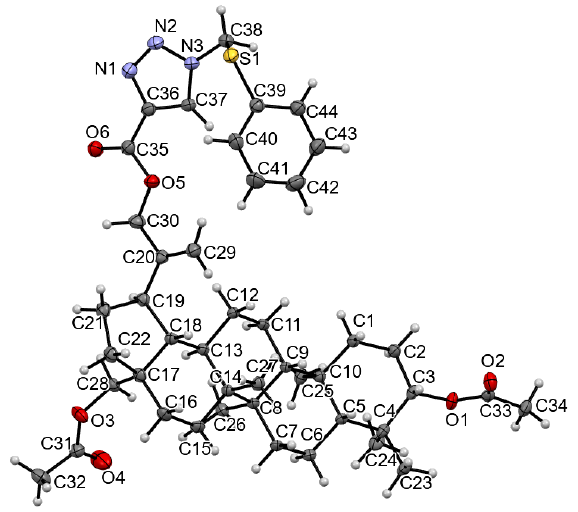
Figure 2. Molecular structure with atom numbering of compound 4 Figure 2 Molecular structure with atom numbering of compound 4 .